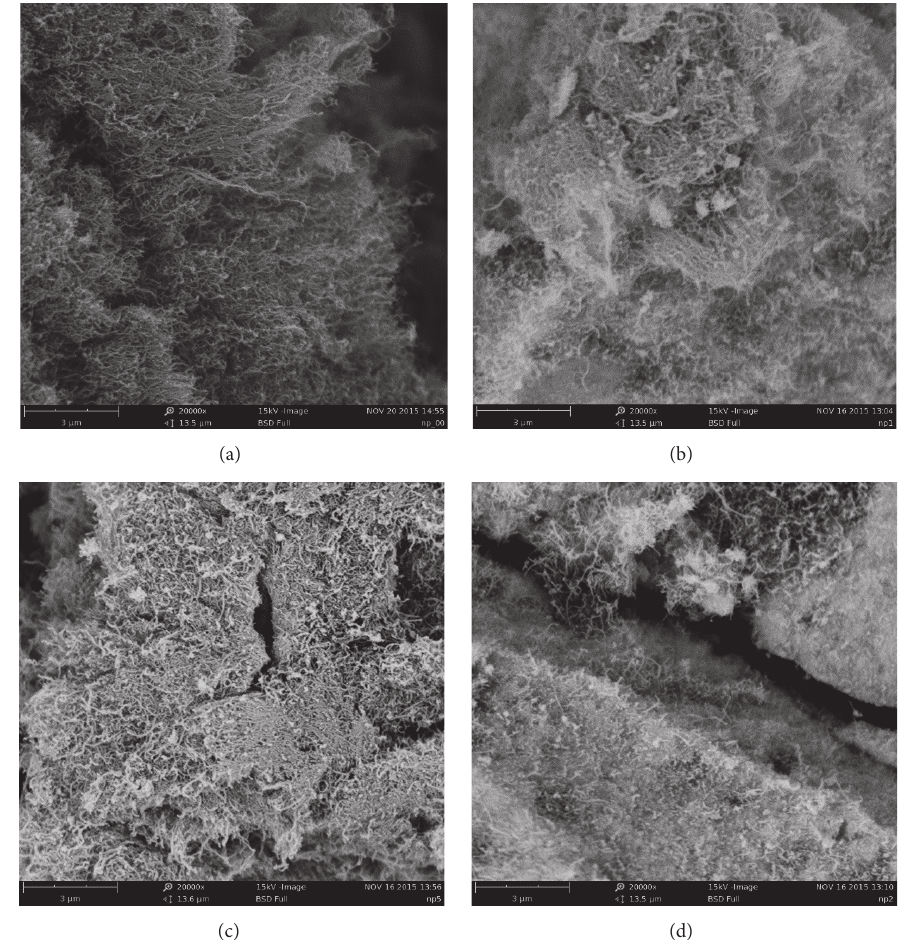
Figure 1: SEM micrographs of CNTs: (a) original; (b) modified with Ni and CeZrO 2 ; (c) modified with Ni; and (d) modified with CeZrO 2 .